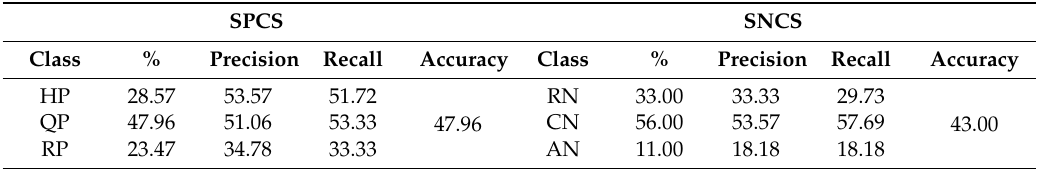
Table 18. Evaluation of the Quality of Sentiment Classification of the Films Reviews Results (Simple Classification, in %). SPCS